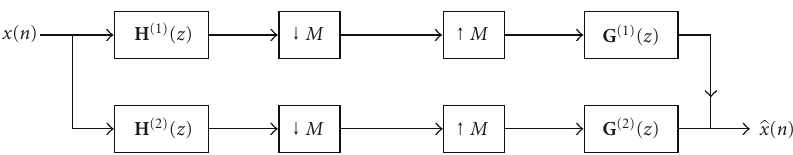
Figure 3: Implementation of the MDFT filter bank as two M -channel filter